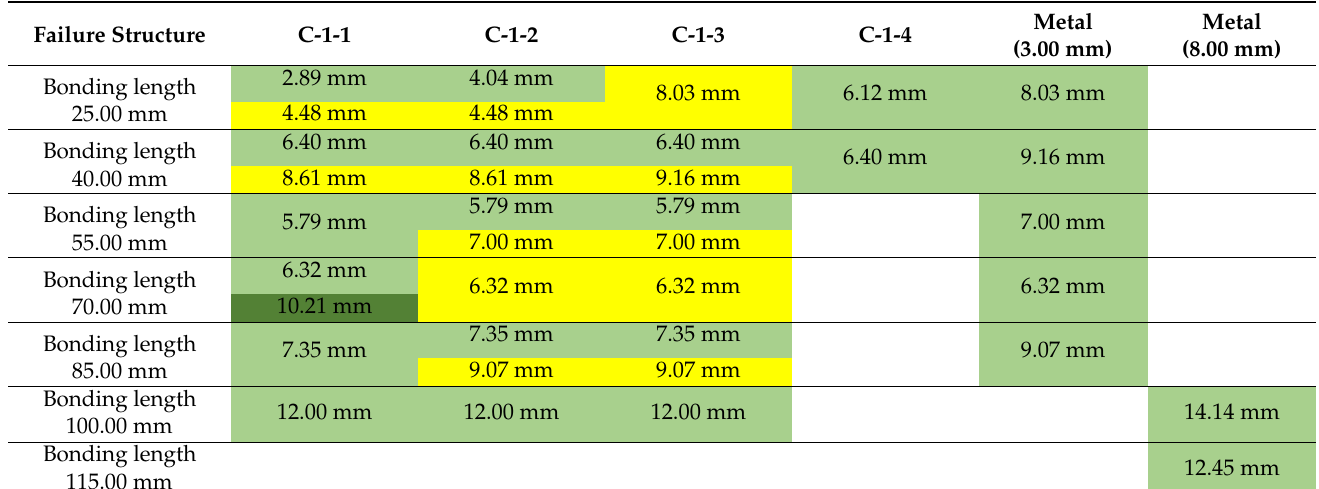
Table 6. Simulated failure mode versus displacement.